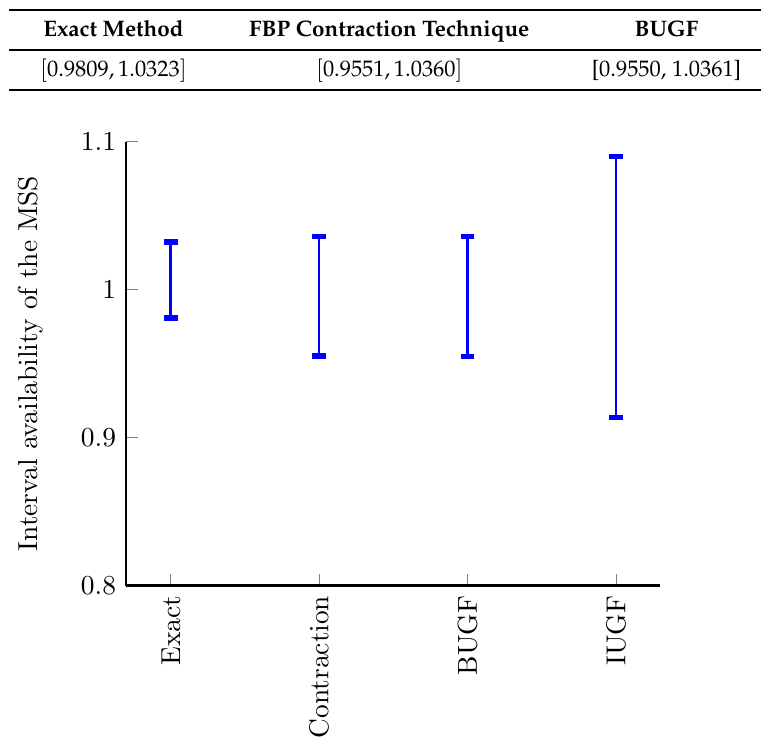
Table 7. Availability when t tends to ∞ for each method.